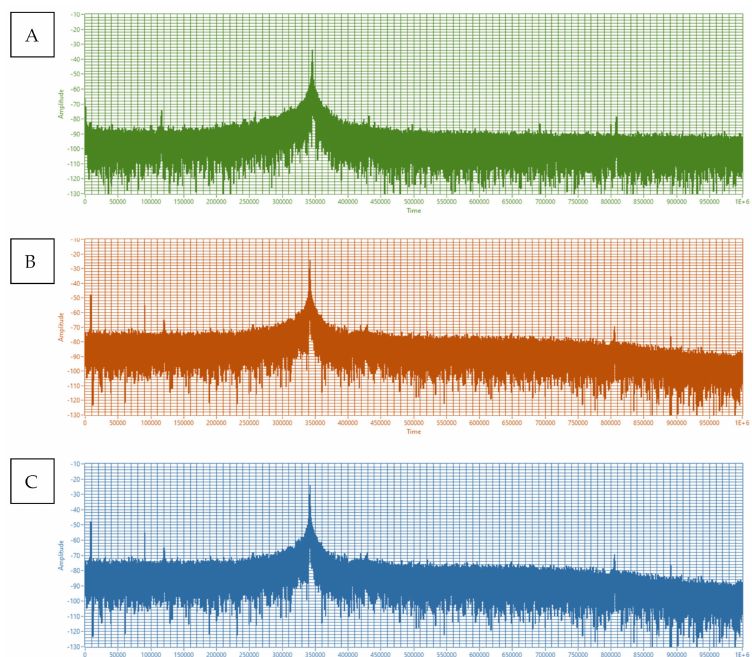
Figure 3. Three samples of the KeFRA-2022 Image dataset: ( A ) real remote signal (Green), ( B ) Fake_Signal_Low_Gain (Orange), and ( C ) Fake_Signal_High_Gain